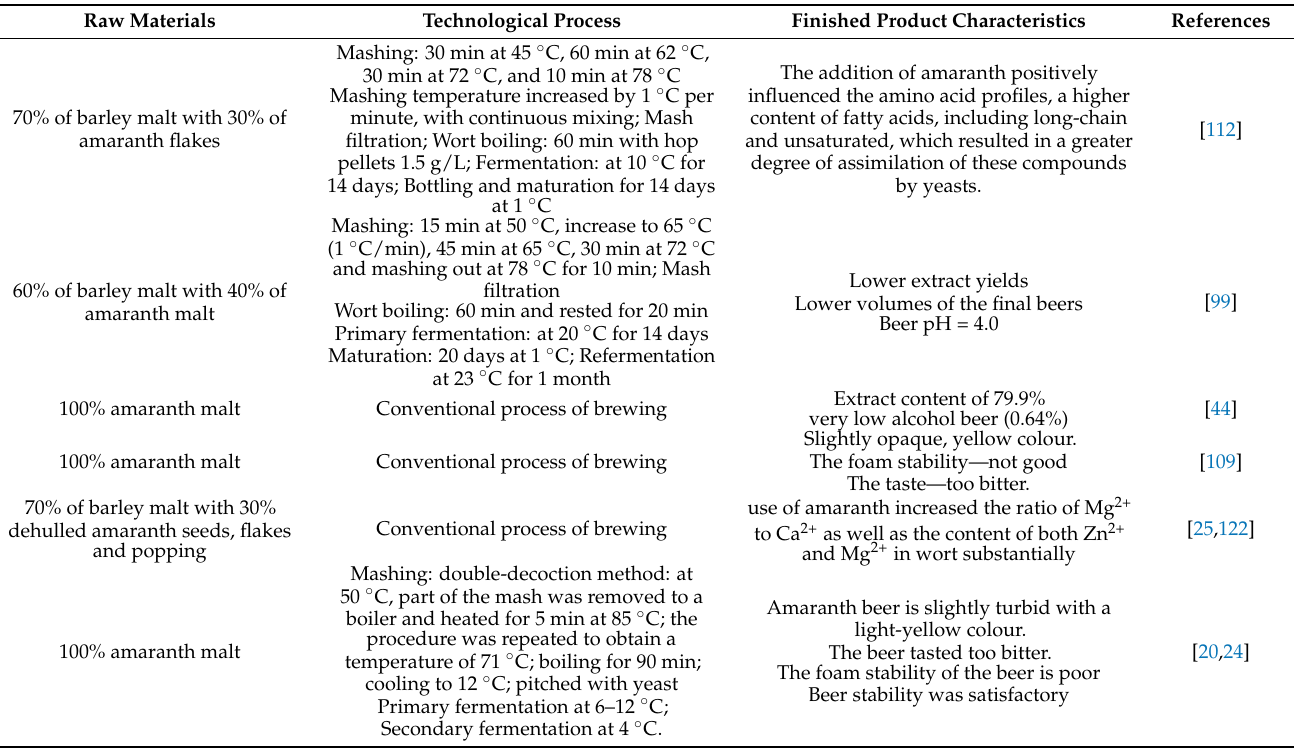
Table 3. Data from the literature on amaranth beer or amaranth malt beer. Raw